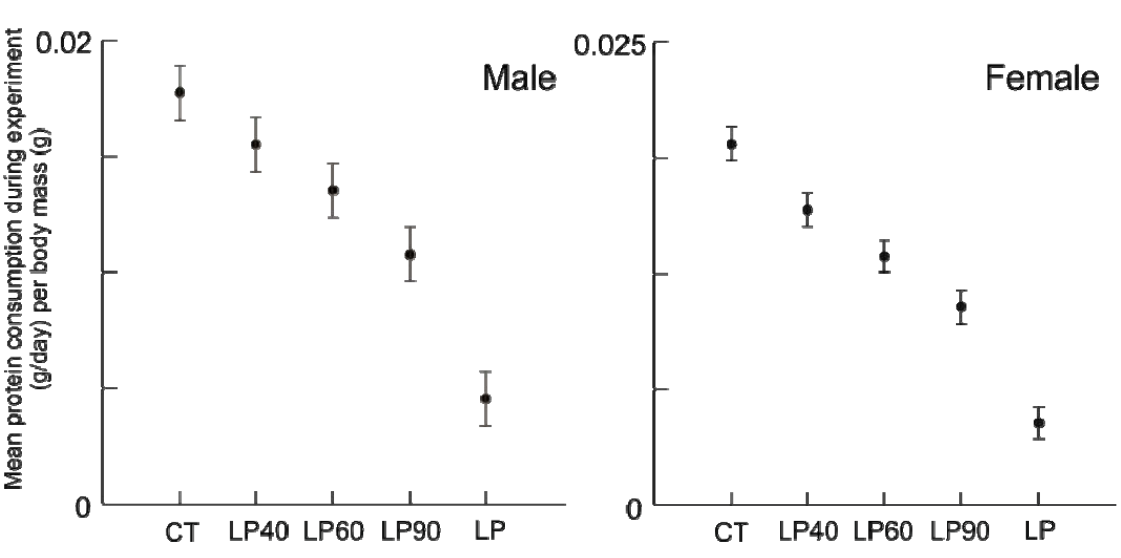
Figure 3. Average standardized calorie consumption (kCal/day/body mass (g)) for males and females for the duration of the experiment (±standard